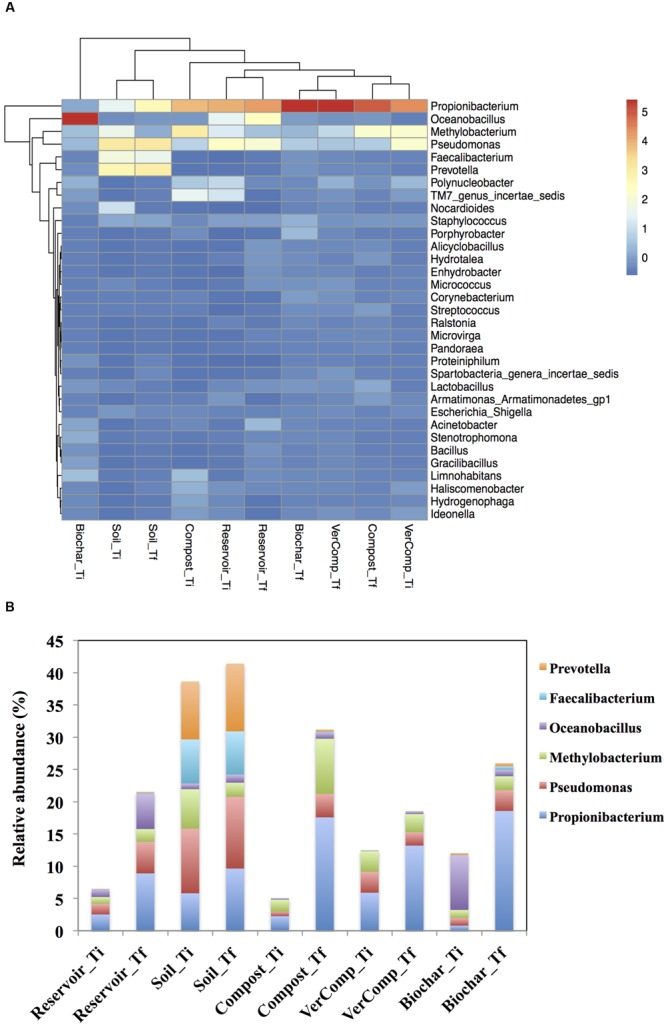
(A) A heatmap showing the comparison and cluster analysis of microbial composition in the pool samples. Indicator scores are based on the OTU abundance in the microbial assemblages. Only the OTUs with a frequency of >1% in at least one sample were shown in the figure and (B) Comparison of abundance of some genera in all treatments between Ti and Tf.